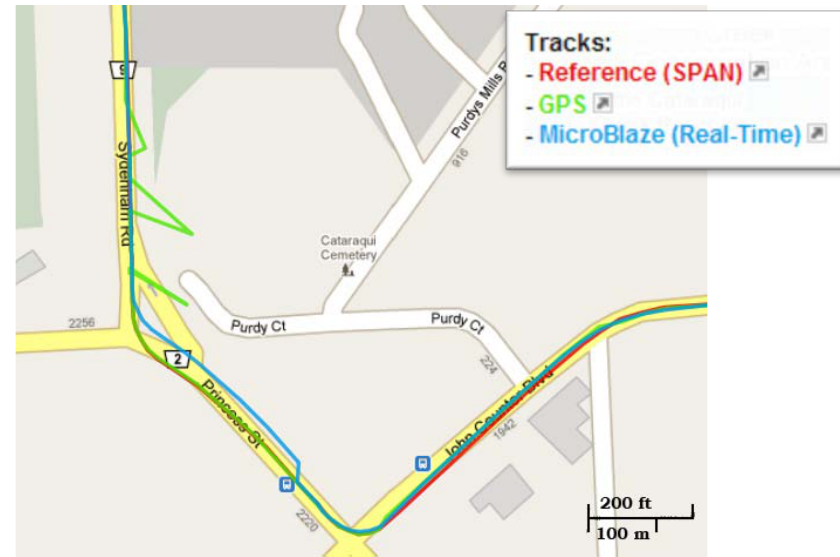
Figure 25. Land Vehicle Trajectory (2): Zooming-in outage (3).